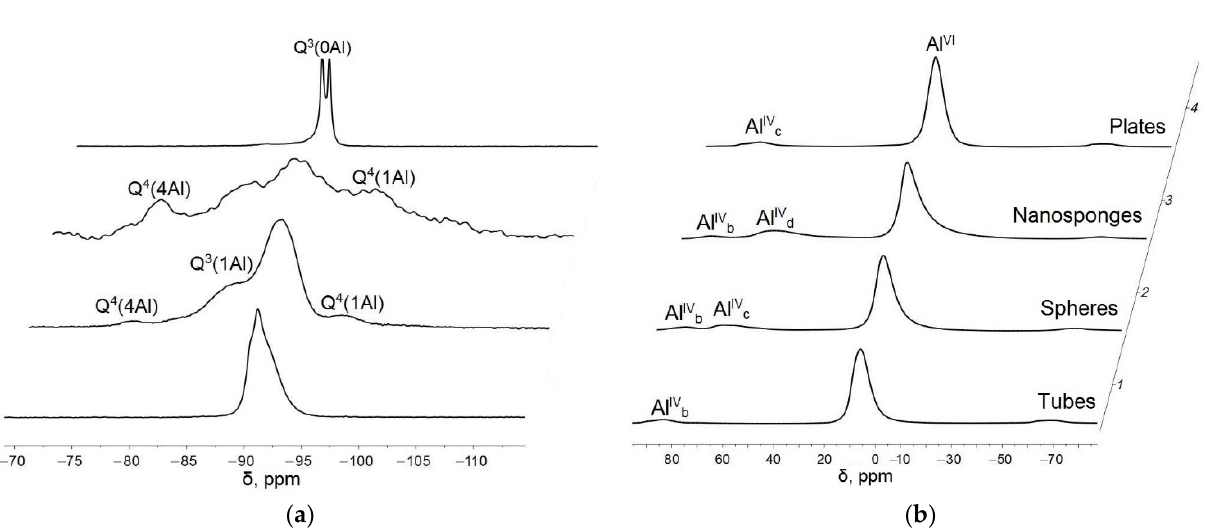
Figure 3. Nitrogen sorption–desorption isotherms of aluminosilicates of different morphology: ( a )—spheres, ( b )—plates, ( c )—sponges, ( d )—nanotubes.